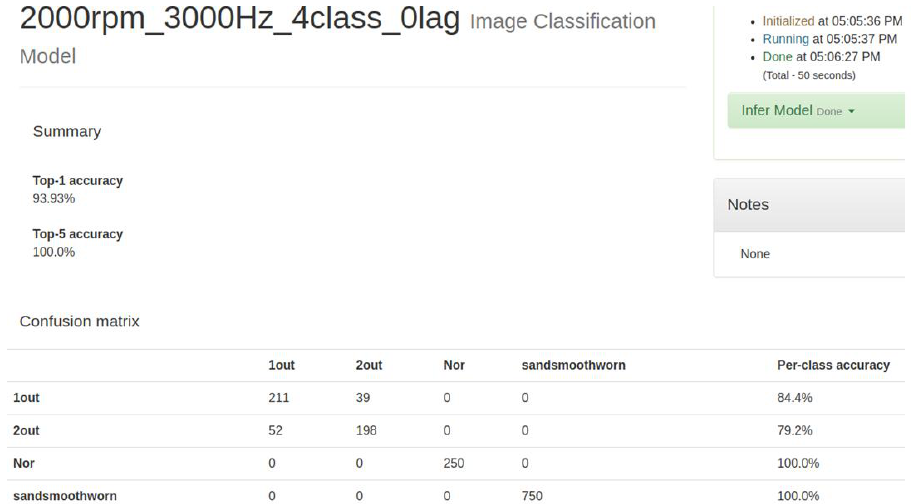
Figure 18. Confusion matrix for the improved formula of symmetrized dot pattern (SDP) as (sampling at 3000 Hz/2000 rpm).